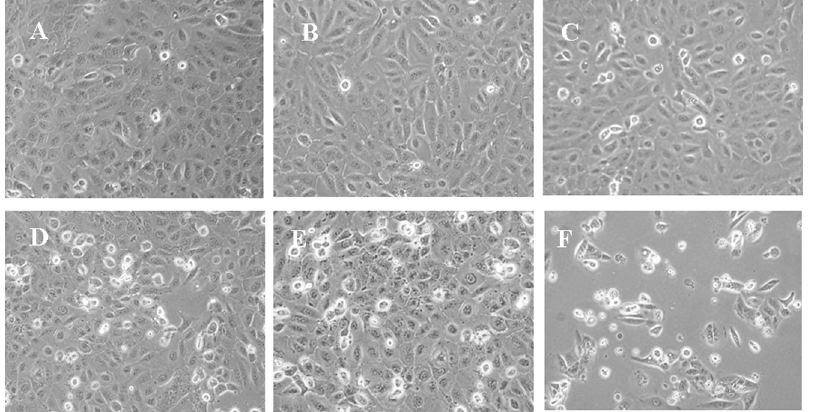
Figure 1. Comparison of the morphology of DU145 cells treated with DTX, OCT alone and the two-drug combination for 48 h. A. Untreated cells; B. 1 nM DTX; C. 100 nM OCT; D. 10 nM DTX; E. Two-drug combination of 10 nM DTX and 100 nM OCT; F. 100 nM DTX.